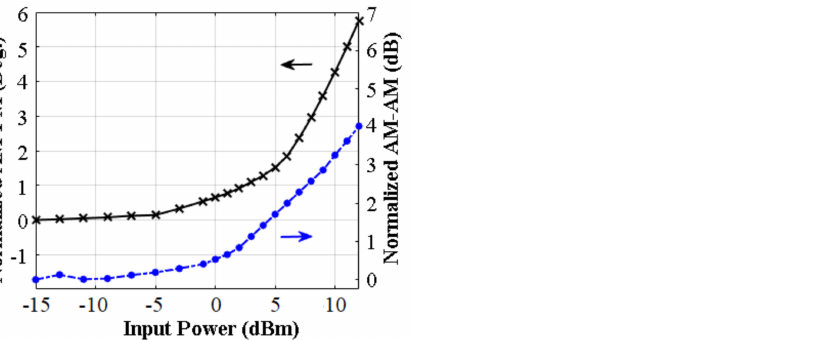
Figure 11. Measured AM–AM and AM–PM distortion across input